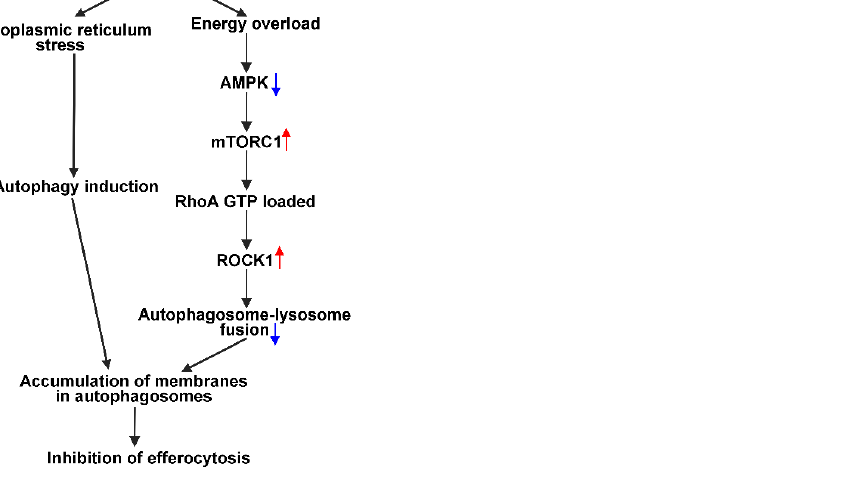
Figure 7. Schematic diagram of signaling pathways induced by palmitate in BMDMs that result in defective autophagy, and consequently in impaired efferocytosis. Interestingly, activation of AMPK could reverse the inhibition of efferocytosis induced by palmitate, and activators of AMPK are already in use in the treatment of obese patients [73 – 75]. Our data indicate that in addition to the well-known effects of AMPK activation on the metabolism, AMPK activators might also correct the impaired efferocytosis in obese patients. Based on our results, inhibitors of ROCK could also be considered. Though our studies focused only on BMDMs, our findings on the effects of palmitate in BMDMs might be applicable for other tissues as well. For example, in hepatocytes, high levels of palmitate were reported to activate mTORC1 [62] and ROCK1 [67], and also to induce a defective autophagy with p62 accumulation observed here [76]. Thus, our data presented in our paper indicate that AMPK activators or ROCK inhibitors might have beneficial effects in the treatment of lipotoxicity also in other tissues of obese individuals by influencing the defective autophagy induced by the accumulation of saturated fatty acids. Author Contributions: L.S., É.G., and T.S. performed the experiments, analyzed the data, and prepared the figures; G.M. performed the confocal microscopy analysis, L.S. prepared the figures, Z.S. won the financial support, designed the experiments, analyzed the data, and wrote the manuscript. All authors have read and agreed to the published version of the manuscript. Funding: This study was supported by the National Research, Development, and Innovation Office. Hungary (124244 and 138162) and by the GINOP-2.3.2-15-2016-00006 project (co-financed by the European Union and the European Regional Development Fund). Institutional Review Board Statement: The study was conducted in accordance with the Declaration of Helsinki and approved by the Institutional Review Board of Animal Care and Use Committee of the University of Debrecen (DEMÁB) with permission numbers 7/2016/DEMÁB and 7/2021/DEMÁB. Informed Consent Statement: Not applicable. Data Availability Statement: Not applicable.